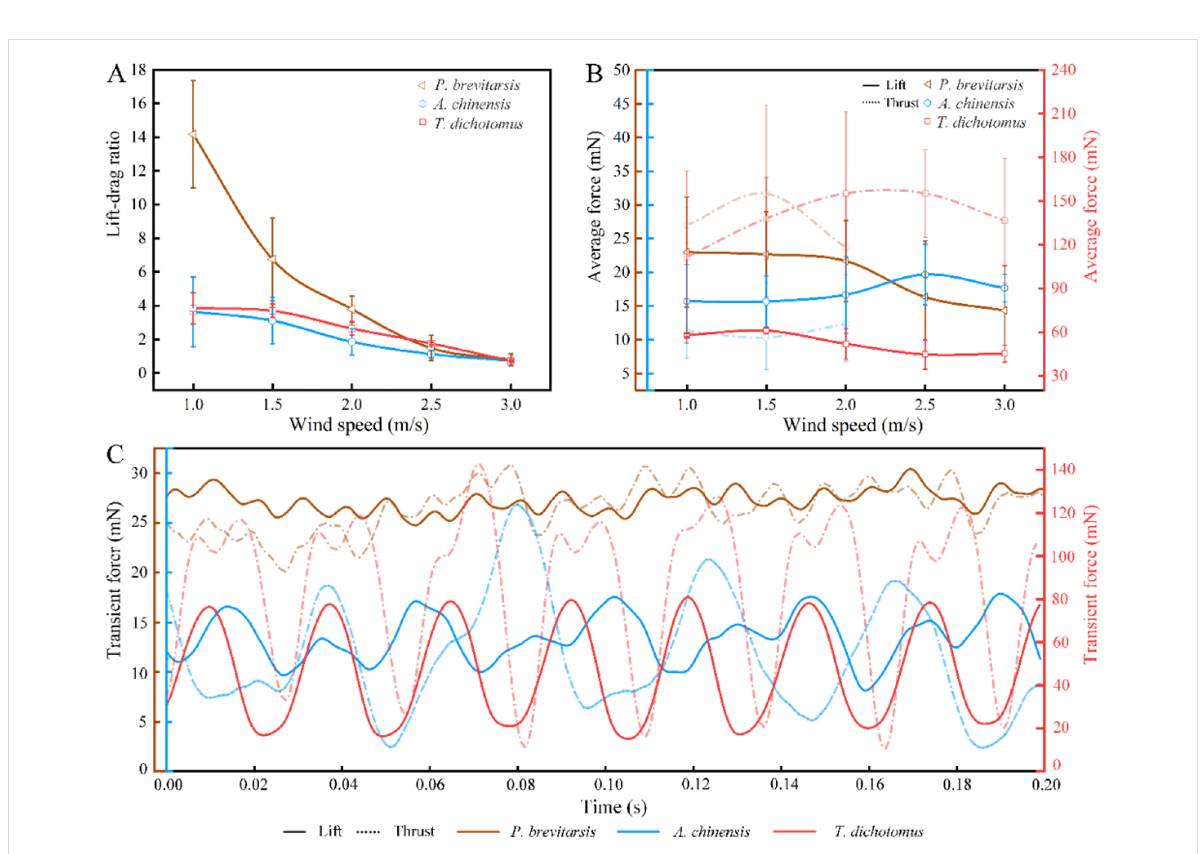
Figure 5: Aerodynamic characteristics of the three beetles. (A), (B), and (C) show the average lift-to-drag ratio, average aerodynamic force at differ- ent wind speeds, and the transient force curves of the three beetles (flapping time period of 0.2 s), respectively.